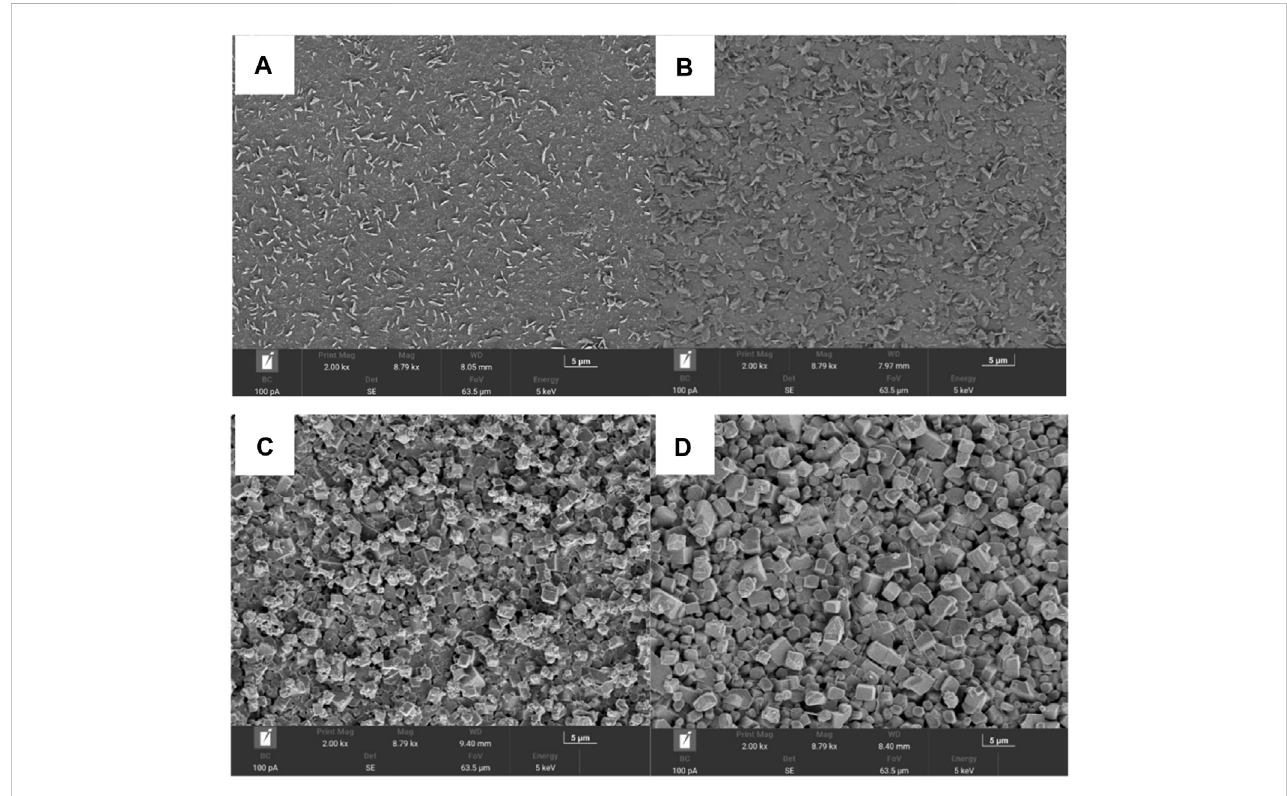
FIGURE 4 The SEM images of gasi fi cation slag-based glass ceramics prepared by (A) at 850 ° C for 1 h, (B) at 850 ° C for 2 h, (C) at 1,050 ° C for 1 h, and (D) at 1,050 ° C for 2 h.